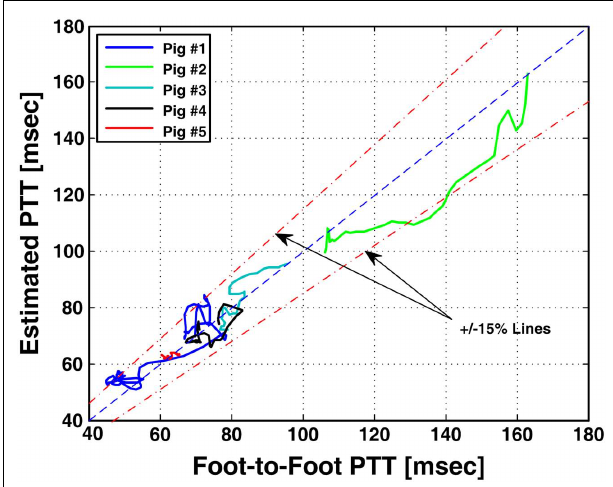
FIGURE 9 | Pulse transit time estimated from radial and femoral arterial pressure waveforms (after a single calibration) versus PTT estimated from aortic and peripheral arterial pressure waveforms via foot-to-foot detection. Adapted from Hahn et al.